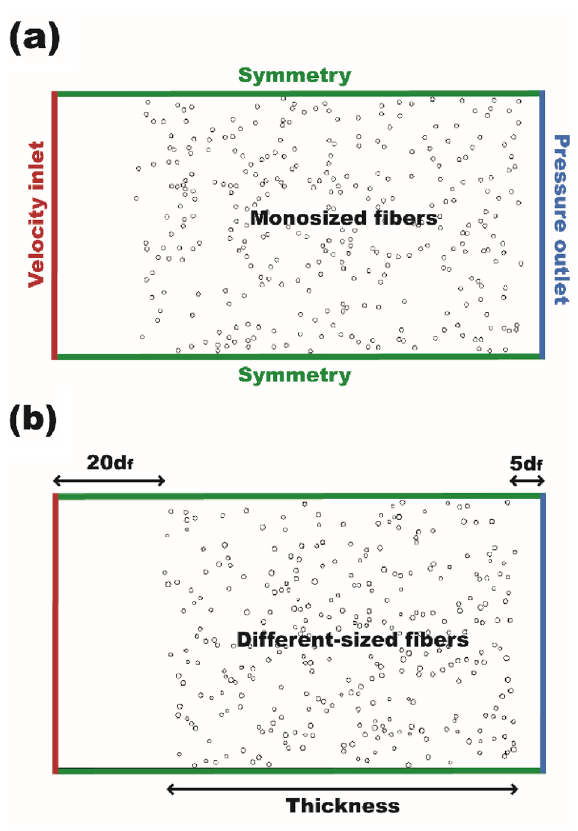
Figure 1. Calculation domains with boundary conditions for ( a ) a monosized fibrous filter and ( b ) a different- sized fibrous